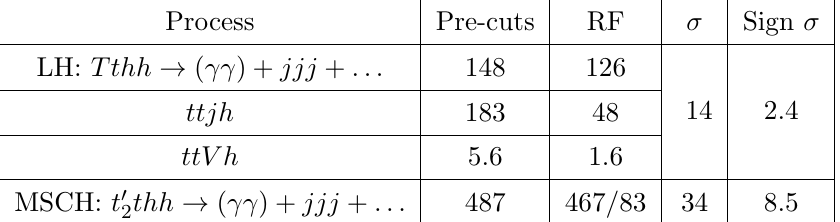
Table 7 . First two columns: signal and background event numbers in the ( (cid:13)(cid:13) ) + 3 j + X channel in a 30 ab (cid:0) 1 sample at a 100 TeV pp collider. Third column: Poisson signi(cid:12)cance [42] for discrim- inating signal+background model from pure background. Last column: Poisson signi(cid:12)cance for discriminating signal+background models with \correct" and \wrong" signs of Y TTh . For MSCH, we list the number of signal/total background events in the RF signal